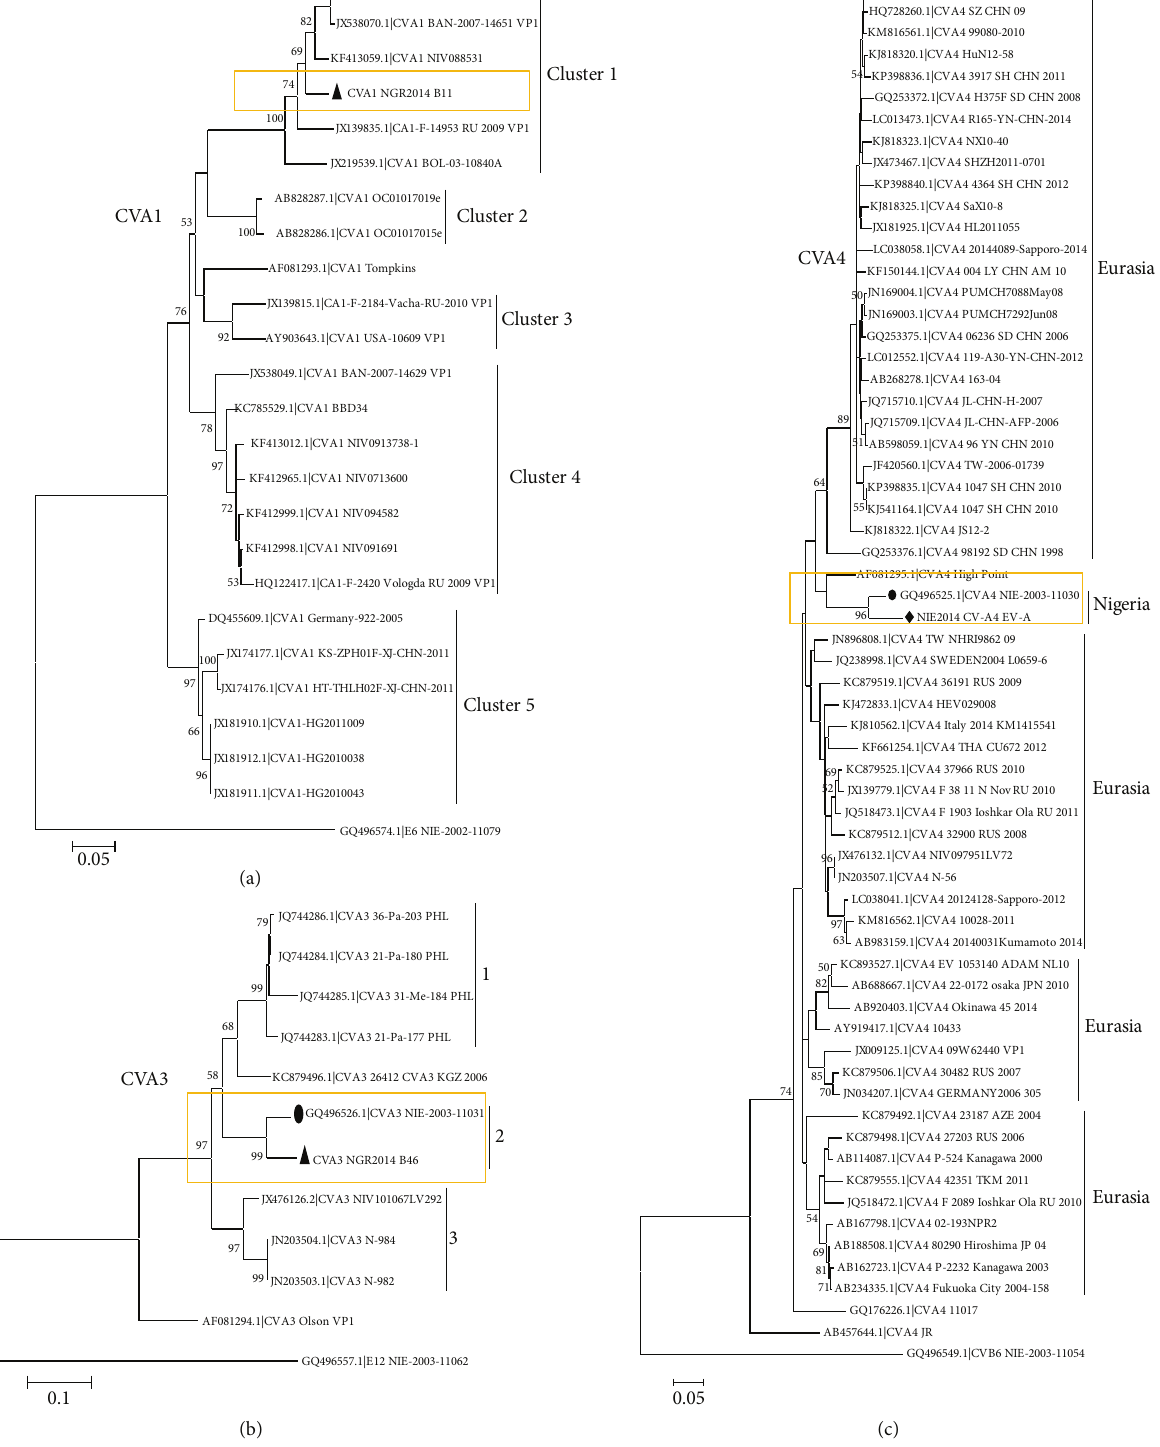
Figure 1: Phylogenetic relationship of recovered CVA1 (a), CVA3 (b), and CVA4 (c) strains. The phylogram is based on alignment of the partial VP1 sequences. The newly sequenced strains and previous strains from the region are highlighted with black triangles or diamonds and circles, respectively. The GenBank accession number of the strains is indicated in the phylogram. Bootstrap values are indicated if >